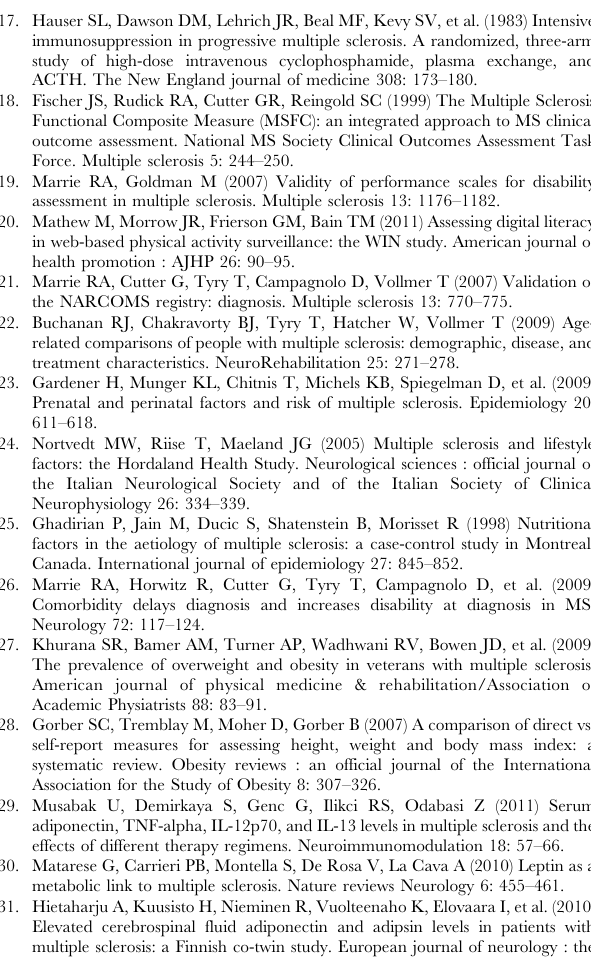
Table S3 Individual and Disease Characteristics of 121 MS Center patients completing MSRS question- naire. Tables S4a–g Distribution of patient and physician scores for individual patients. Table S5 Comparison of PLM members’ individual and disease characteristics with those of patients followed in the NARCOMS